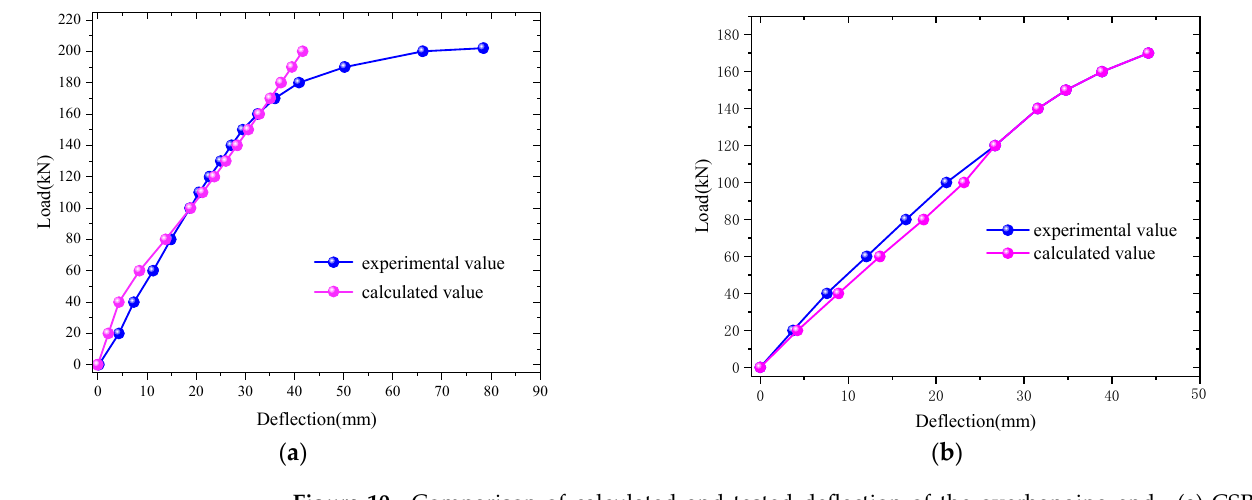
Figure 10. Comparison of calculated and tested deflection of the overhanging end. ( a ) CSB-1. ( b ) CSB-2.